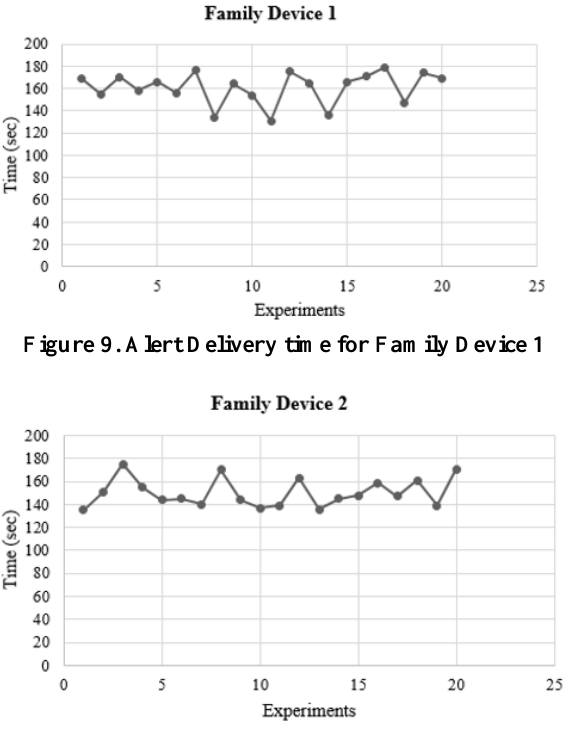
Figure 10. Alert Delivery time for Family Device 2